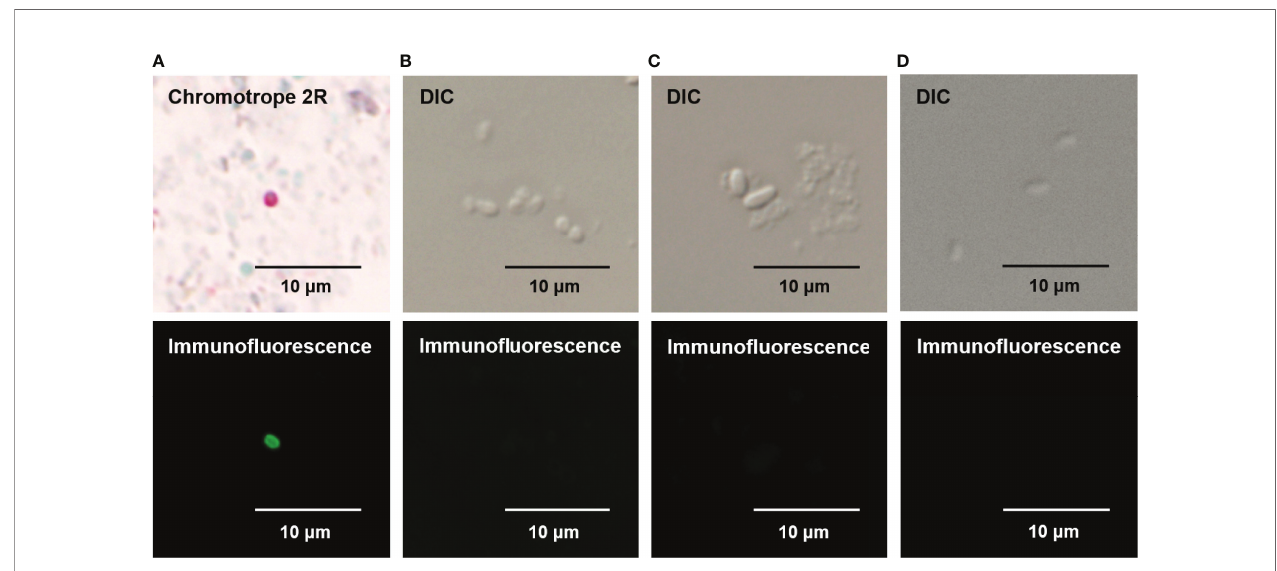
FIGURE 5 | Speci fi city of direct immuno fl uorescence assay for Enterocytozoon bieneusi developed with mAb against EbSWP1. (A) Detection of E. bieneusi spores by Chromotrope 2R-staining (the upper panel) and immuno fl uorescence (the lower panel). (B) Detection of E. hepatopenaei spores using differential interference contrast (DIC) microscopy (the upper panel) and the EbSWP1-based immuno fl uorescence assay (the lower panel). (C) Detection of E. cuniculi spores using DIC microscopy (the upper panel) and the EbSWP1-based immuno fl uorescence assay (the lower panel). (D) Detection of E. coli bacteria using DIC microscopy (the upper panel) and the immuno fl uorescence assay (the lower panel).